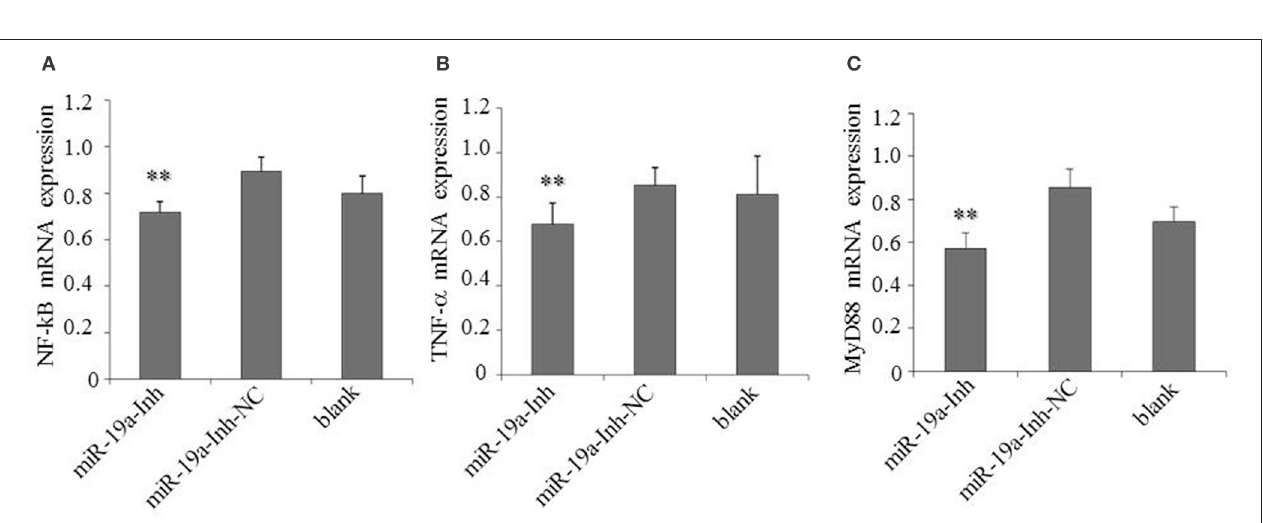
FIGURE 10 | Over-expression of gga-miR-19a activates NF- κ B, TNF- α and MyD88 in DF-1 cells transfected with gga-miR-19a or the negative control. A mock transfection was used as a blank. At 48 h post-transfection, the expression of NF- κ B (A) , TNF- α (B) , and MyD88 (C) were measured by RT-qPCR. A mock transfection was used as the blank. All samples were normalized to GAPDH . All values are represented as the mean ± SD of three independent experiments in triplicate. Significant differences are denoted as ** P < 0.01.